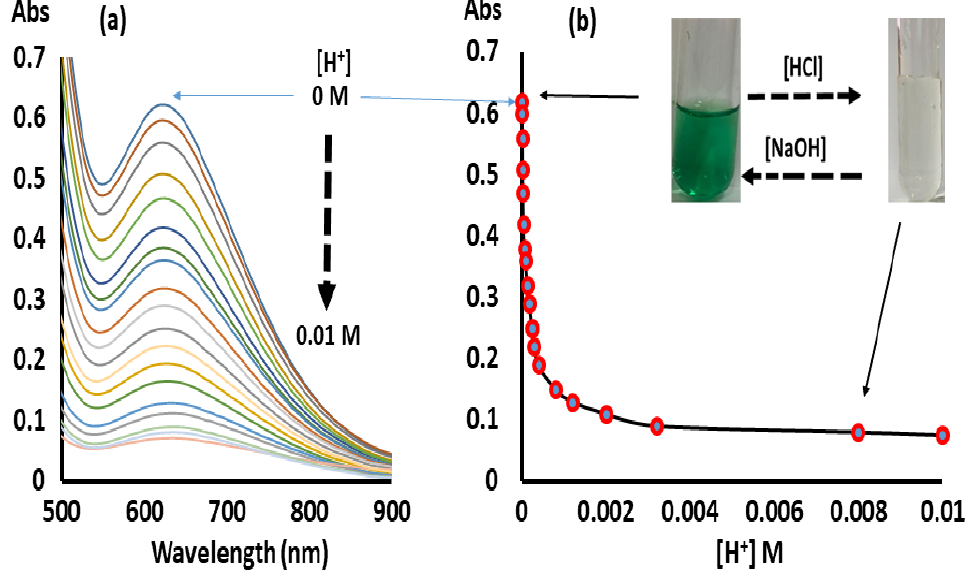
Figure 7. [H + ]-dependent visible spectra of complex 1 in water at RT ( a ) and Abs. vs. [H + ] relation at constant λ max = 625 nm ( b ).